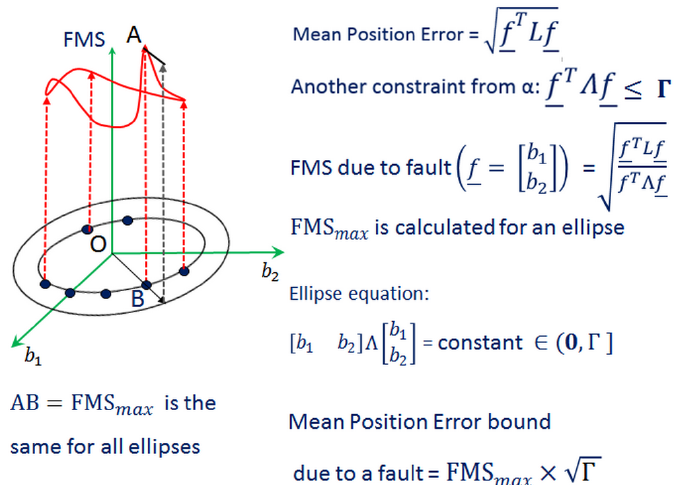
Figure 4. Illustration of FMS for a hypothetical two dimensional fault vector. The maximum FMS (FMS max ) for each ellipse is the same. The mean position error bound is the product of maximum FMS √ Γ and